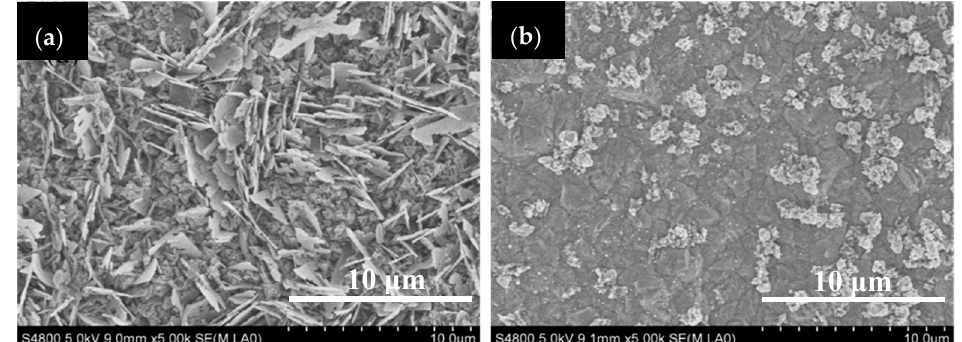
Figure 7. SEM images of carbon deposits on the surface of TiO 2 coatings with different particle sizes after the coking test: ( a ) the flow rate of H 2 diluent gas is 1.52 L/min (corresponding to Figure 5(A1)) and ( b ) the flow rate of CO 2 is 80 mL/min (corresponding to Figure 5(C1)).